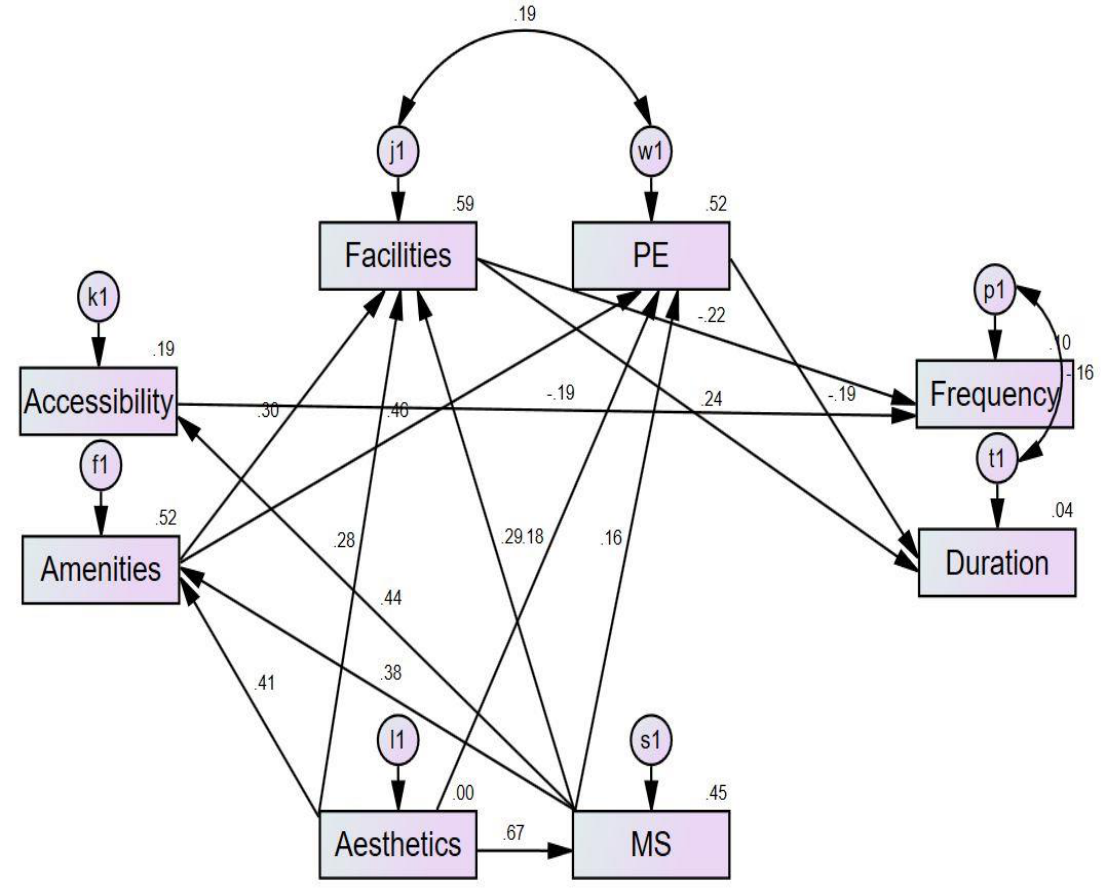
Figure 1. Final influencing model.